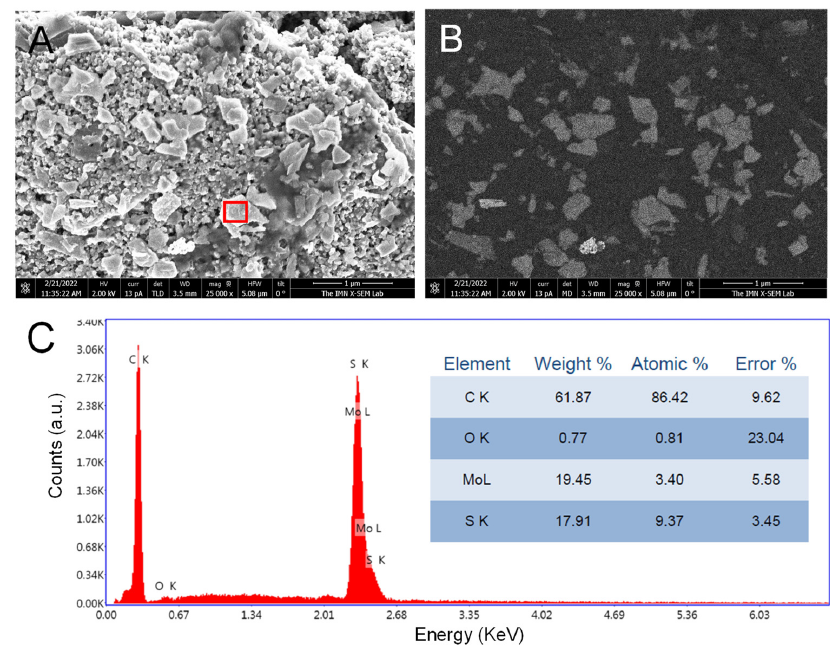
Figure 3. (A) Secondary and (B) backscattered electrons SEM images of CSPE/MoS 2 -NS. (C) EDX spectra on the MoS 2 -NS area marked on Figure 3A. spectra on the MoS 2 -NS area marked on Figure